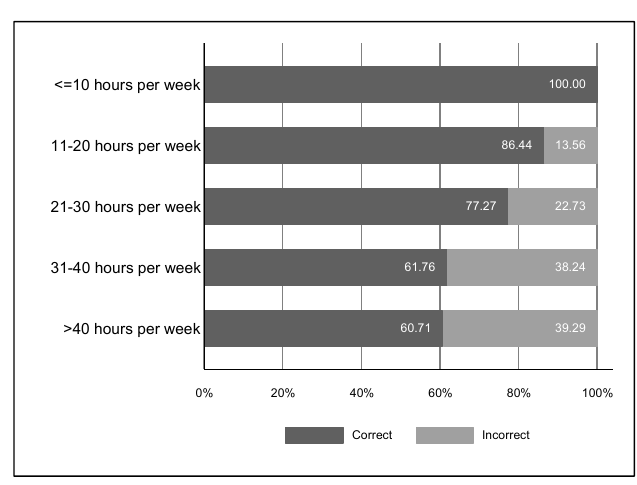
Interviewer behavior for collecting administrative information II and interviewer’s working hours per